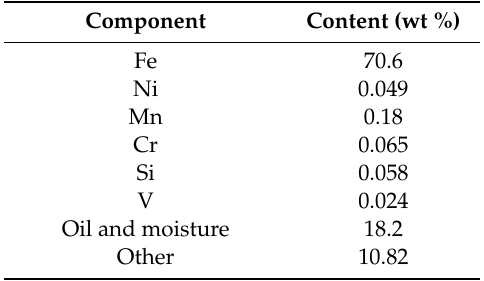
Table 1. Main composition of oily cold rolling mill (CRM)